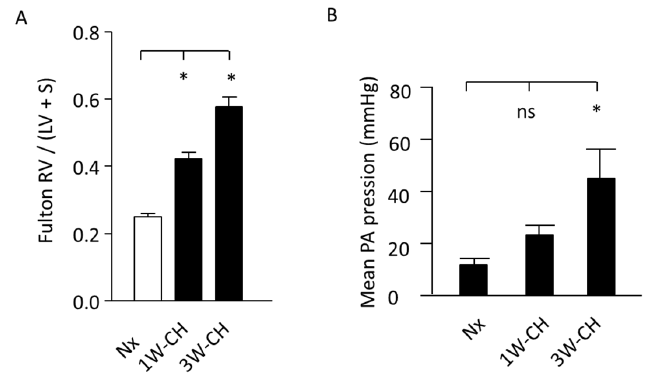
Figure 1. Increase in mean pulmonary artery pressure (mPAP) and RV hypertrophy. ( A ) Fulton index, a cardiac PH marker in normoxic (Nx) or in CH conditions. n = 20. ( B ) Pressure (mean pul- artery pressure) increased in CH condition, regardless of time. (*) p < 0.05; (ns) p >